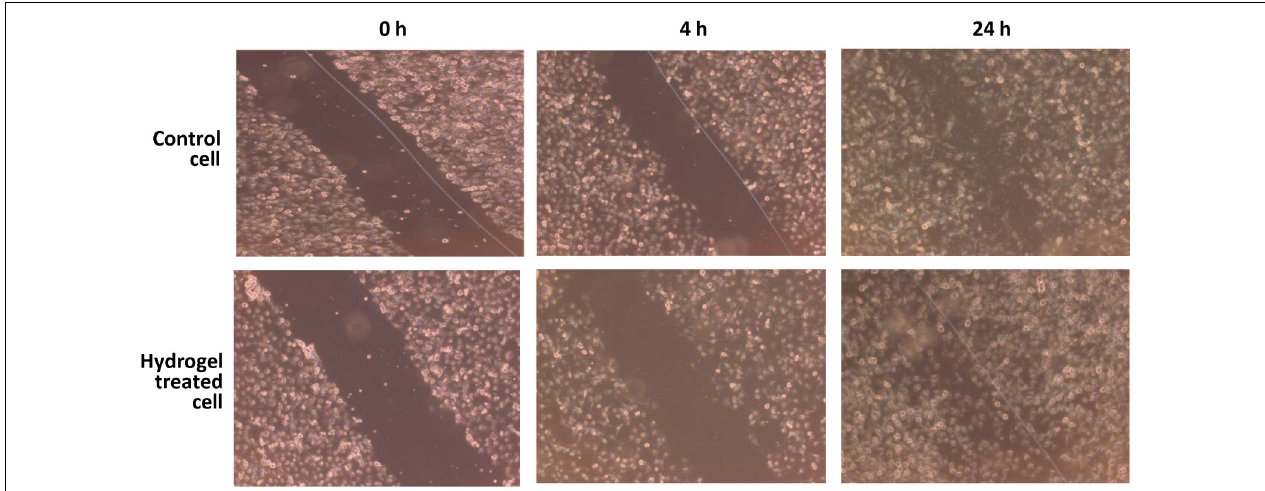
FIGURE 6 | Wound-healing assay was performed to examine the migration of human keratinocyte (HaCaT) cells through scratch assay. Photographs were taken at 0, 4, and 24 h following the initial scratch.